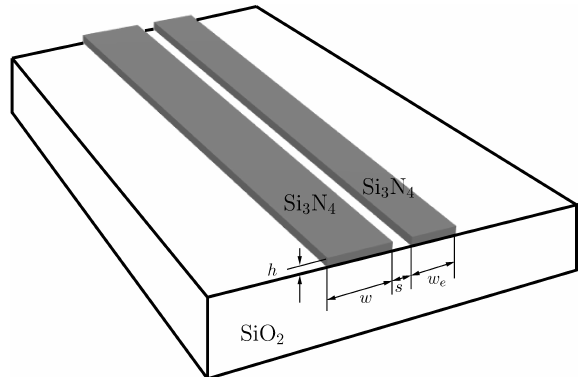
Figure 2. Geometry of silicon nitride straight asymmetric coupled waveguides with an aqueous cover used for reference purposes. System parameters are also annotated in the figure and defined in the